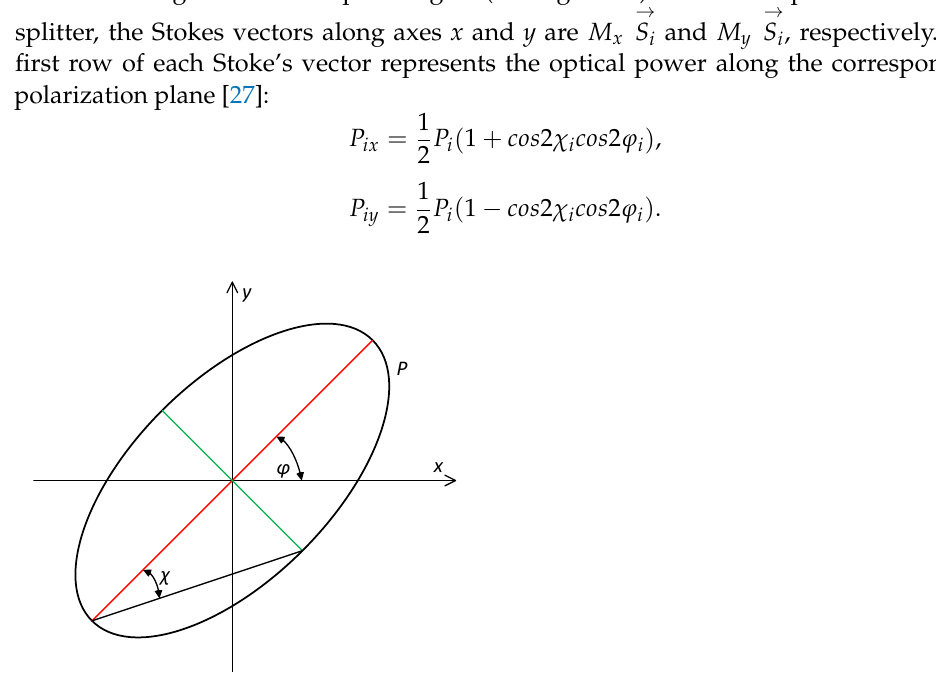
Figure 10. Polarization